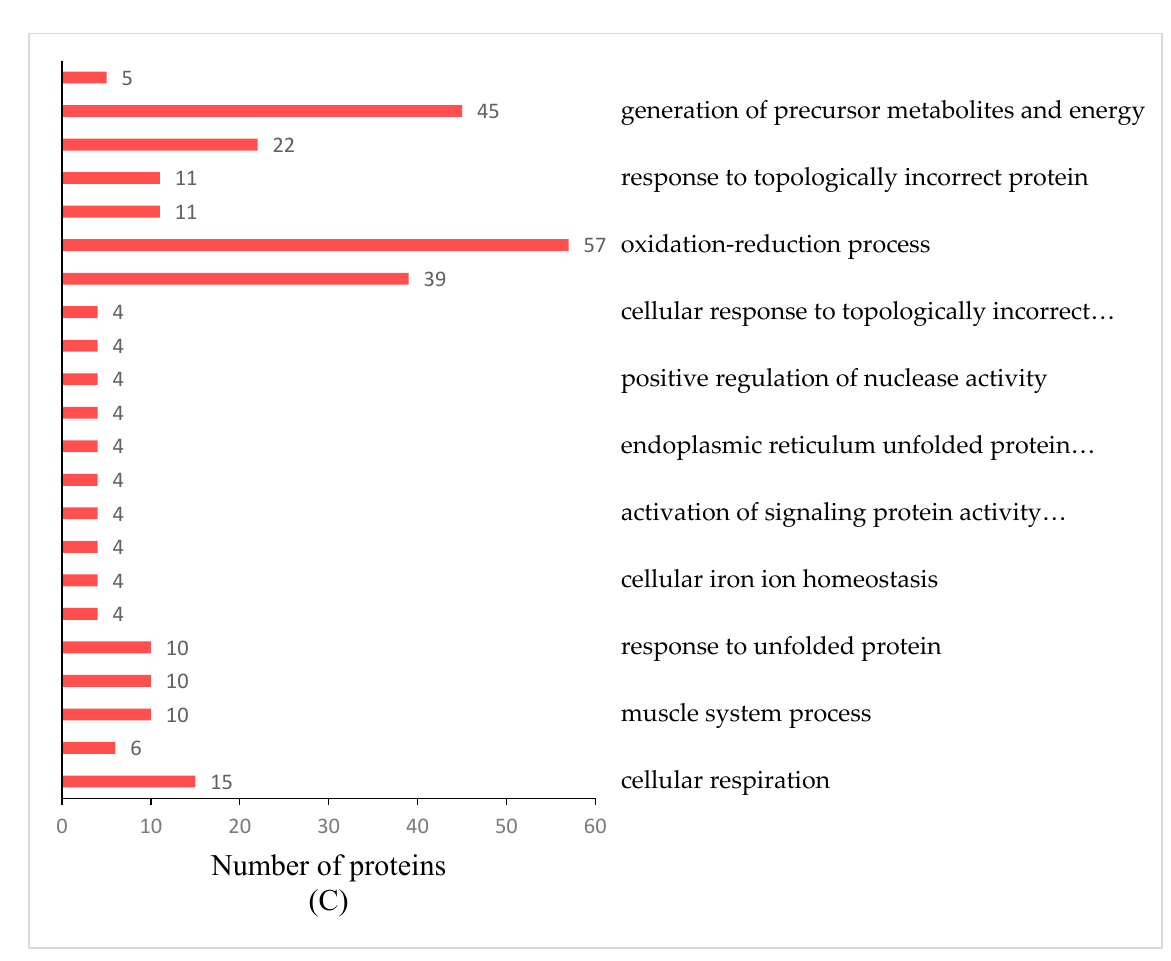
Figure 4. GO Enrichment Analysis of DEPs. Cellular component (( A ); p < 0.05), molecular function classification (( B ); p < 0.05) and biological processes (( C ); p < 0.01) of differentially expressed proteins according to the GO enrichment analysis. The orders of the columns are arranged according to p -values (low to high).